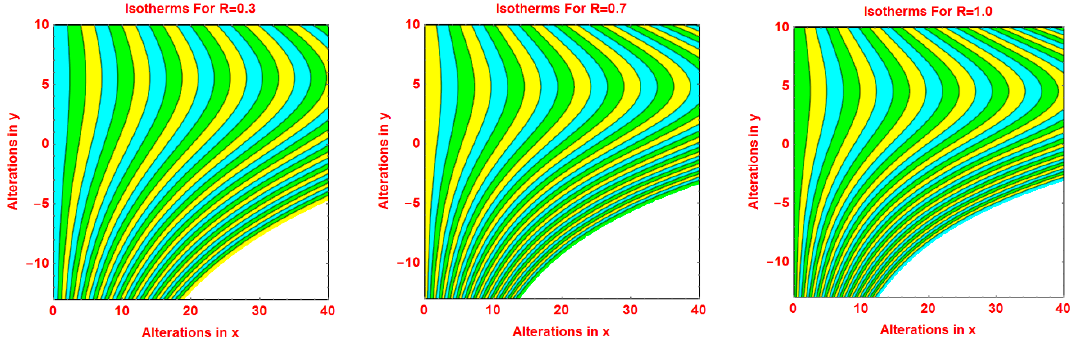
Figure 9. Effects of different values of R on isotherms pattern.